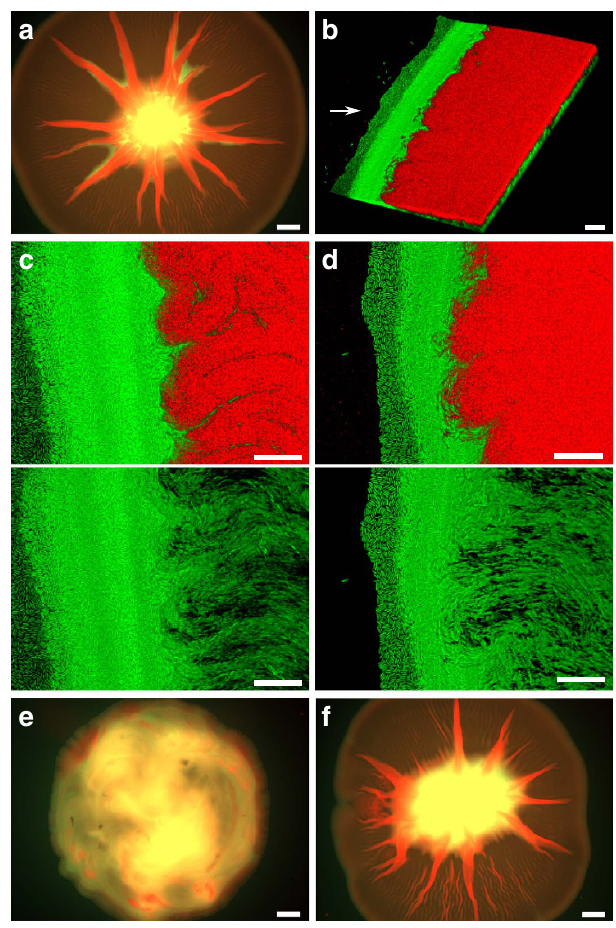
Figure 3 | M and D self-organize into characteristic spatial patterns. ( a ) Epifluorescence image of a mixed colony of fluorescently tagged M (green) and D (red) on day 8. ( b ) Corresponding confocal laser scanning microscopy image of the edge. The white arrow points at the edge of the colony. ( c , d ) Confocal images of the edge on day 2 ( c ) and day 22 ( d ). The two images within each panel are identical except the red channel has been removed from the bottom images. ( e , f ) Day 8 epifluorescence image of a mixed colony disturbed daily from day 3 ( e ) or only once on day 3 ( f ). All mixed colonies were initiated at a 1:1 ratio. Scale bars, 2mm or 20 m m in epifluorescence and confocal images, respectively. All confocal images are three-dimensional